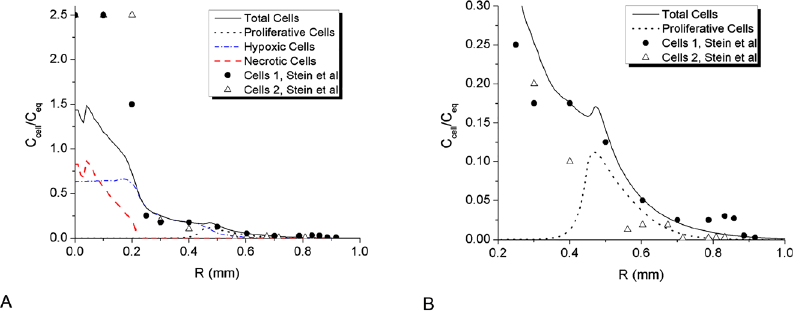
Figure4: Comparisontheresultsofcalculationwithexperimentaldataforday3ofMTSgrowthobtainedin[68]fortheU87WTcell line (solid spheres). The fi gures present calculated distributions of total cell density obtained for D O2 = 86.4 mm 2 /day; Proliferative, hypoxic and necrotic cells in different scales for clear comparison (A) and